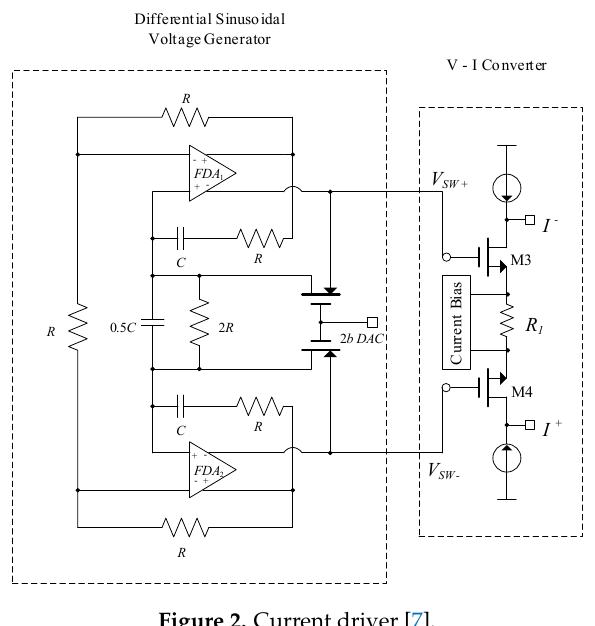
Figure 2. Current driver [7].